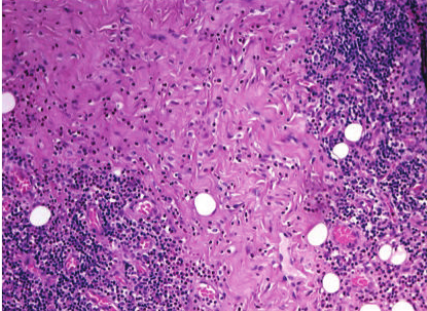
Figure 5: Scattered eosinophils are seen throughout (H&E staining,